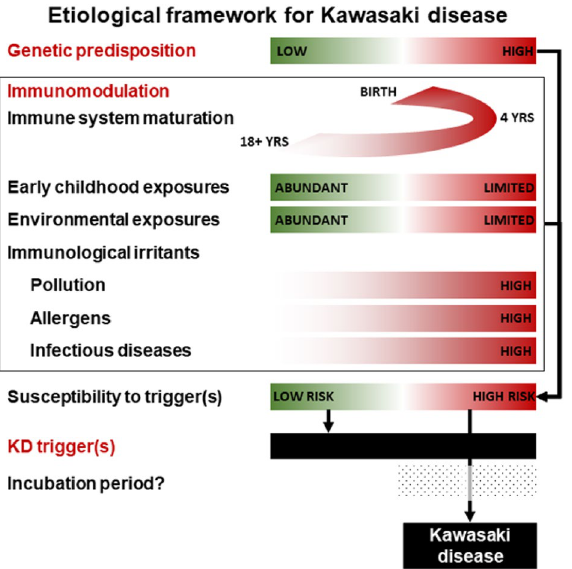
Figure 5. Hypothetical framework of Kawasaki disease (KD) etiology and risk based on published evidence, our previously published environmental case control study 21 and the evidence presented in our current spatiotemporal model of the spatiotemporal distribution of KD. Red indicates higher risk while green indicates lower